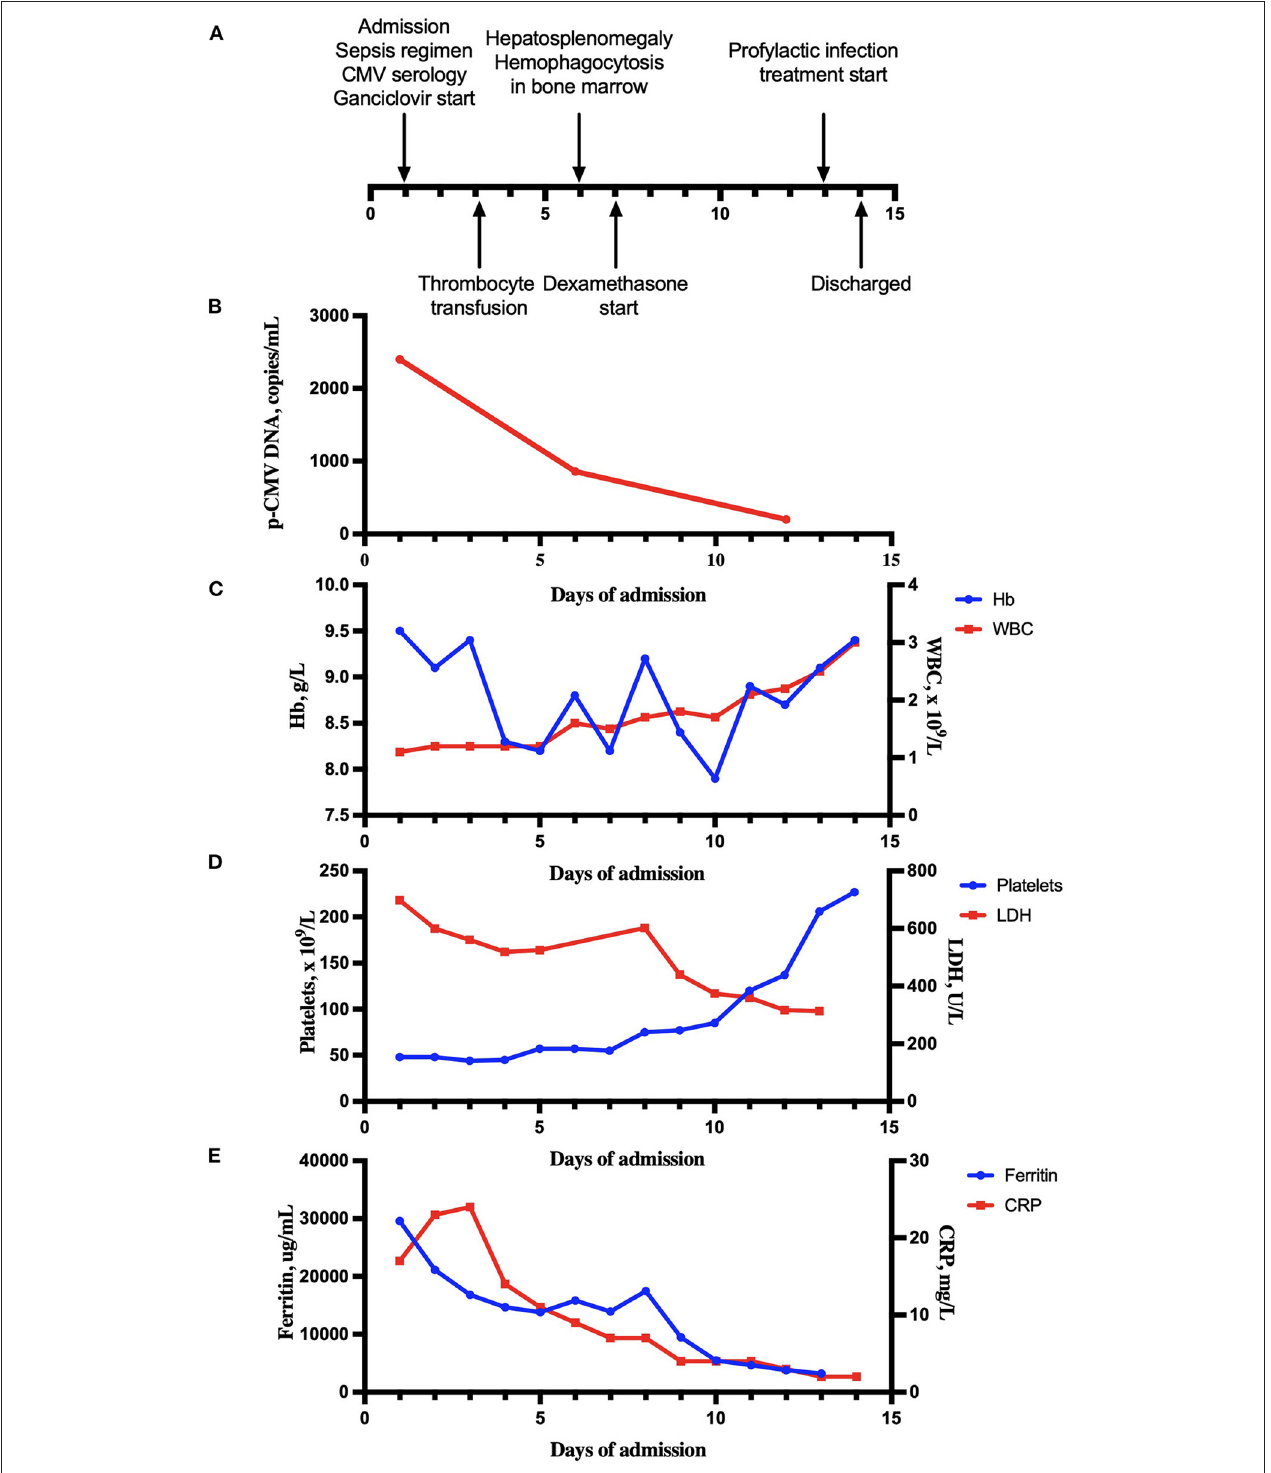
FIGURE 1 | Clinical and laboratory evaluation during hospitalization. (A) A timeline of diagnostic and therapeutic events over the course of admission. (B) Plasma CMV-DNA PCR transcript levels over the course of treatment. (C) Hemoglobin (Hb) and white blood cell count (WBC) during hospitalization. (D) Platelets and lactate dehydrogenase (LDH) during hospitalization. (E) Ferritin and C-reactive protein (CRP) during hospitalization.